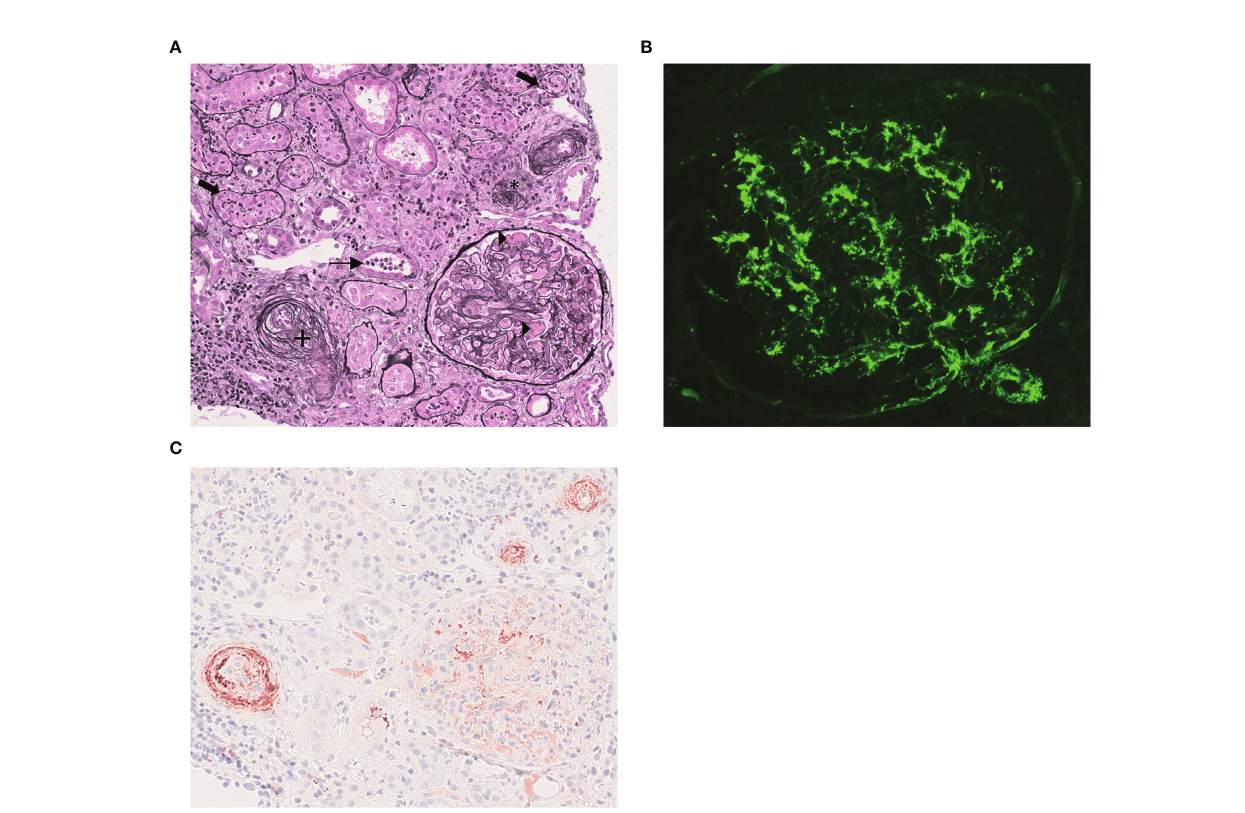
FIGURE 1 | Kidney biopsy fi ndings. (A) Light microscopy analysis: Fibrin within glomerular capillary loops (black triangle). Small inter-lobular artery with intimal mucoid alterations and endothelial cells swelling (+). Arteriolar occlusion (*). Polymorphonuclear in fi ltration with tubulitis (thick arrows) and granular casts (thin arrow) (Jones methanamine silver staining, x200). (B) Immuno fl uorescence stucy showing predominant mesangial and sub-endothelial C3 deposits in glumeruli and in glomerular arteriole. (Anti-C3c fl uorescein isothiocyanate-conjugate x400). (C) Immunochemistry study showing positive C5b-9 staining in arterioles, inter-lobular artery and glomeruli within the mesangium (Mouse IgG, B7 antineoepitope, 1 x40). 1 Kindly provided by Prof. P. Morgan (Cardiff Intitute of Infection&Immunity, UK).